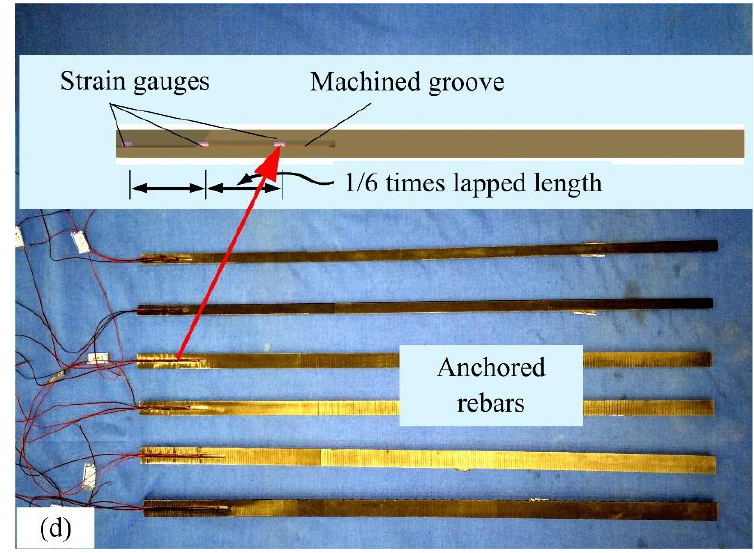
Figure 4. Precast construction process. ( a ) Mold with spiral hoops, rebar, and duct ( b ) Grout pouring ( c ) Anchored rebar with the locators ( d ) Arrangement of strain gauges.